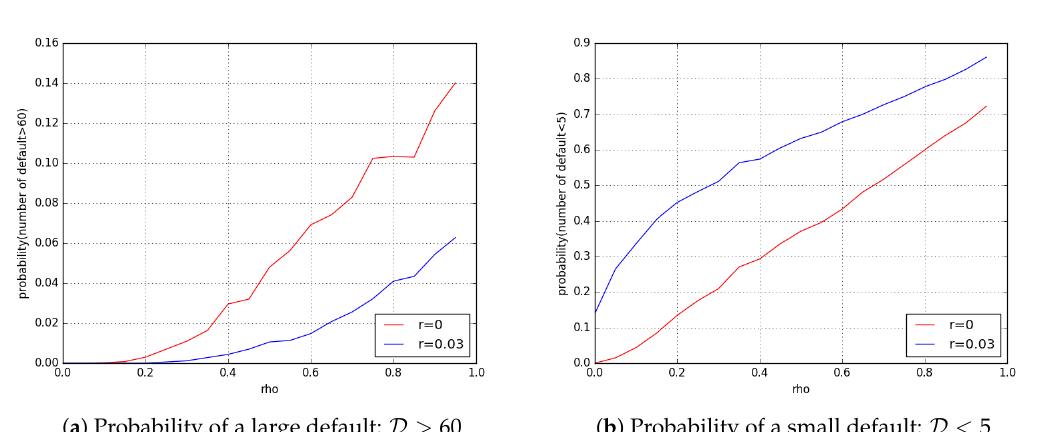
Figure 7. Empirical estimates of the probabilities of large and small defaults: P ( D > 60 ) and P ( D < 5 ) , respectively, as a function of correlation between portfolio process ρ 0 at different interest rates. We use the following parameters: N = 100 banks, 5000 simulations, µ i = σ i = 0.1 for i = 1, . . . , N , and interbank flow rates c ij = 0 for i , j = 1, . . . , N .